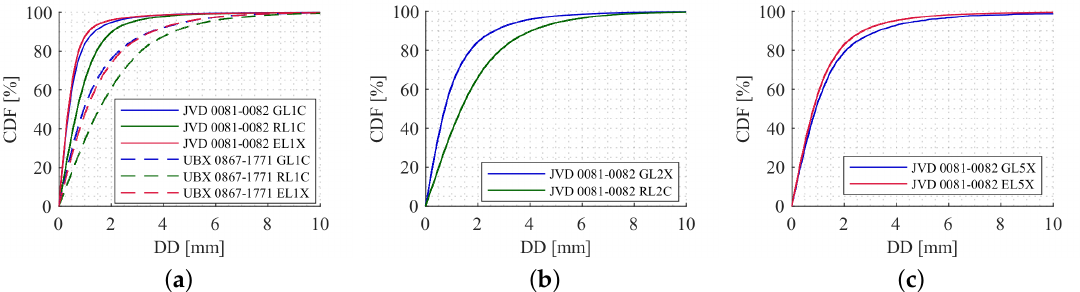
Figure 12. Cumulative distribution functions (CDF) for carrier phase DDs from all satellites on L1 ( a ), L2 ( b ) and L5 ( c ) frequencies for GPS (blue), GLONASS (green) and Galileo (red). The geodetic-grade combination is displayed with solid lines, the high sensitivity combination with dashed